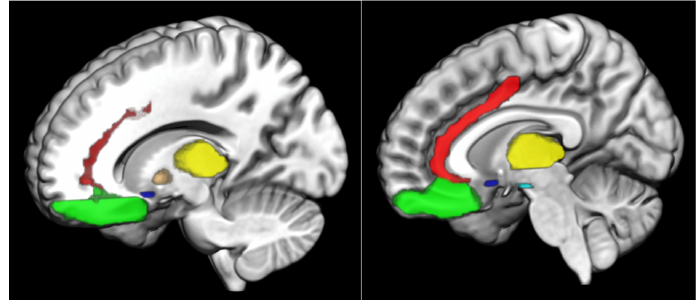
Figure 1. Main brain areas of the reward system anterior cingulate cortex: red; globus pallidus: orange; nucleus accumbens: royal blue; orbitofrontal cortex: neon green; thalamus: yellow; ventral tegmental area: cyan.